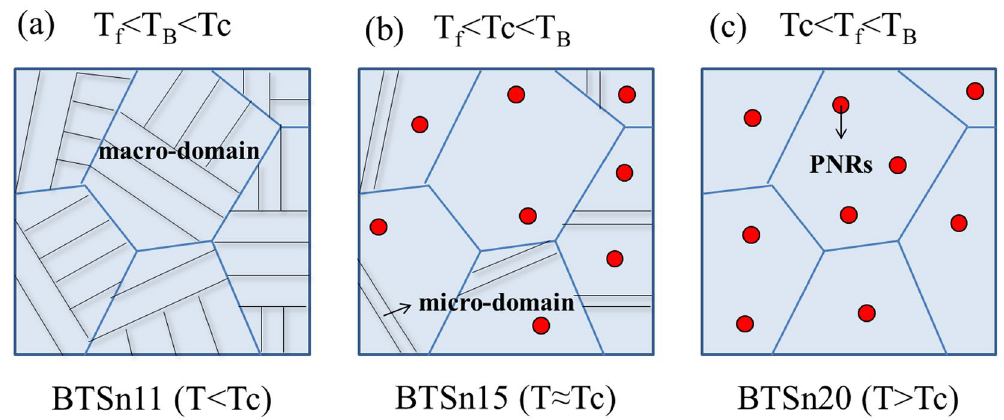
Figure 5. Schematic evolution of domain structures with the increasing of tin concentrations at the measured temperature T : ( a ) BTSn11, ( b ) BTSn15 and ( c )